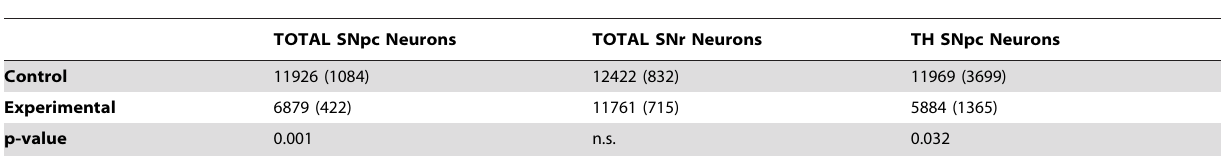
TOTAL SNpc Neurons TOTAL SNr